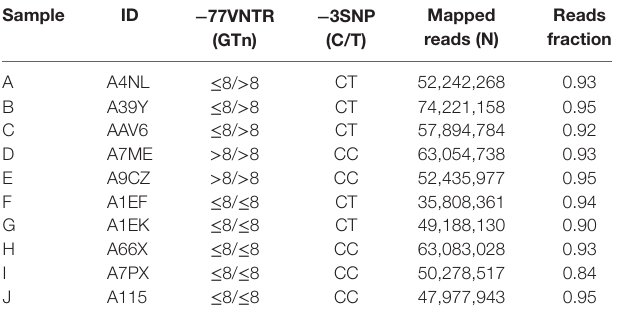
TaBle 1 | RNAseq samples analyzed in this